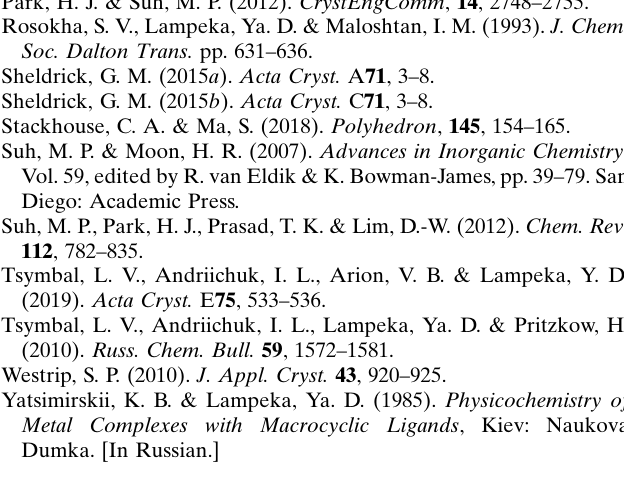
Table 4 Experimental details. Crystal data Chemical